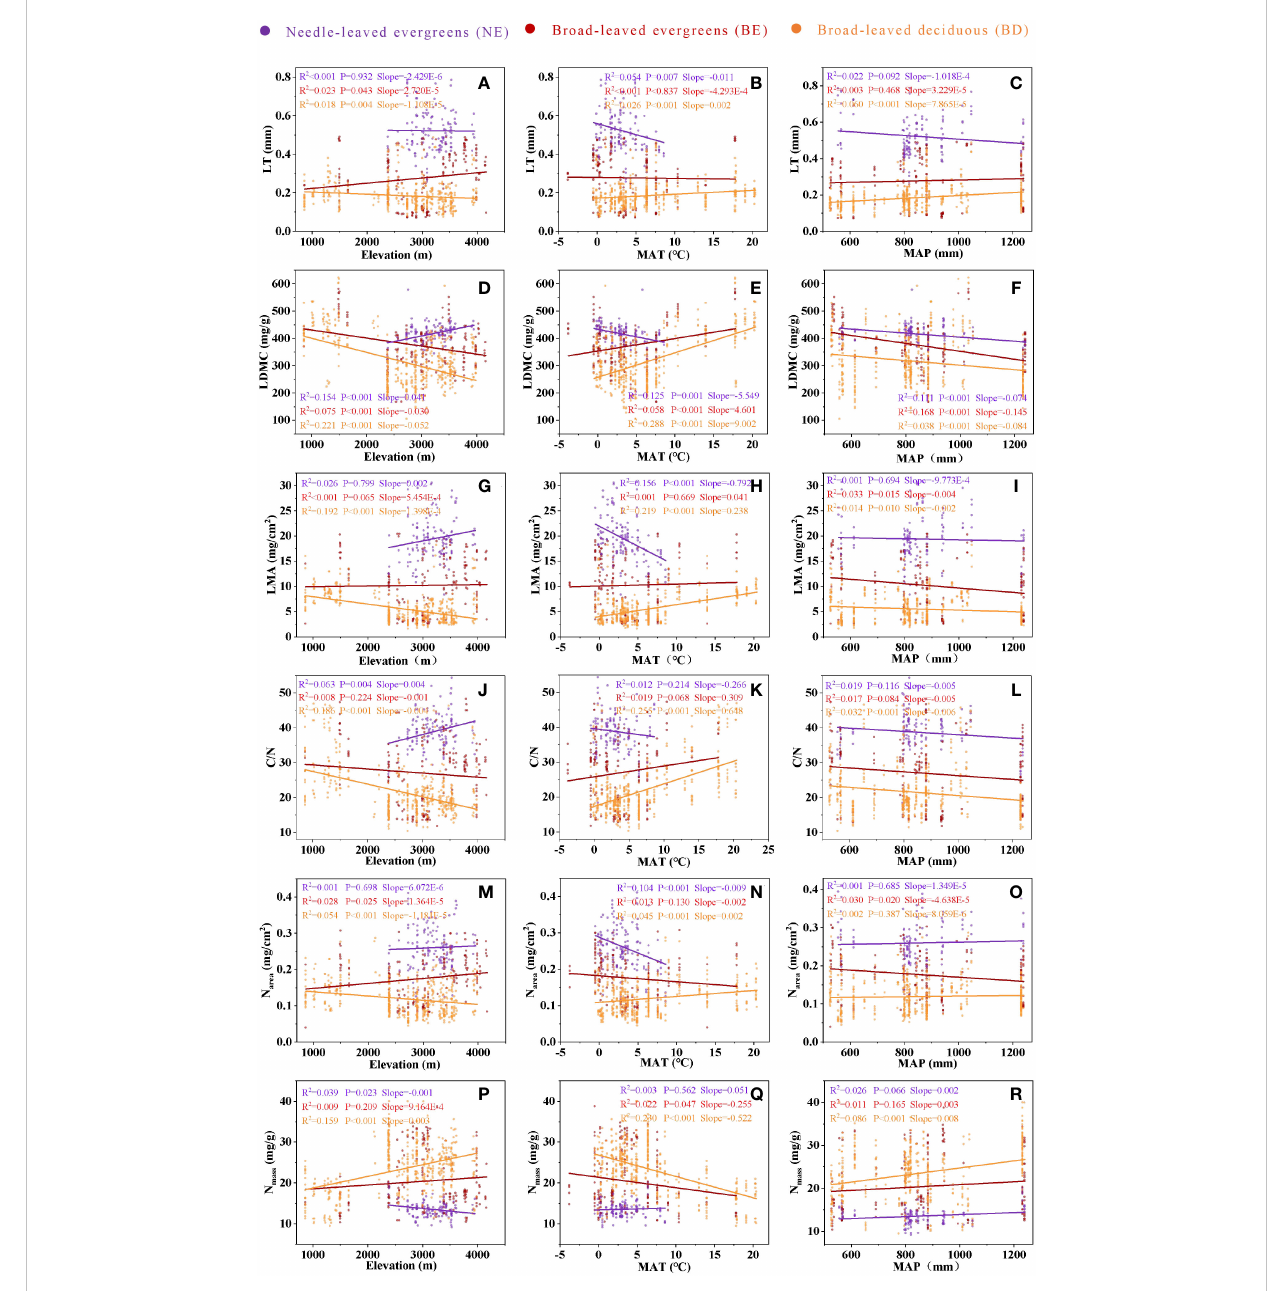
FIGURE 4 The relationship between LT and elevation (A) , between LT and MAT (B) , between LT and MAP (C) , between LDMC and elevation (D) , between LDMC and MAT (E) , between LDMC and MAP (F) , between LMA and elevation (G) , between LMA and MAT (H) , between LMA and MAP (I) , between C/N and elevation (J) , between C/N and MAT (K) , between C/N and MAP (L) , between Narea and elevation (M) , between Narea and MAT (N) , between Narea and MAP (O) , between Nmass and elevation (P) , between Nmass and MAT (Q) , between Nmass and MAP (R) . Needle-leaved evergreens (NE),